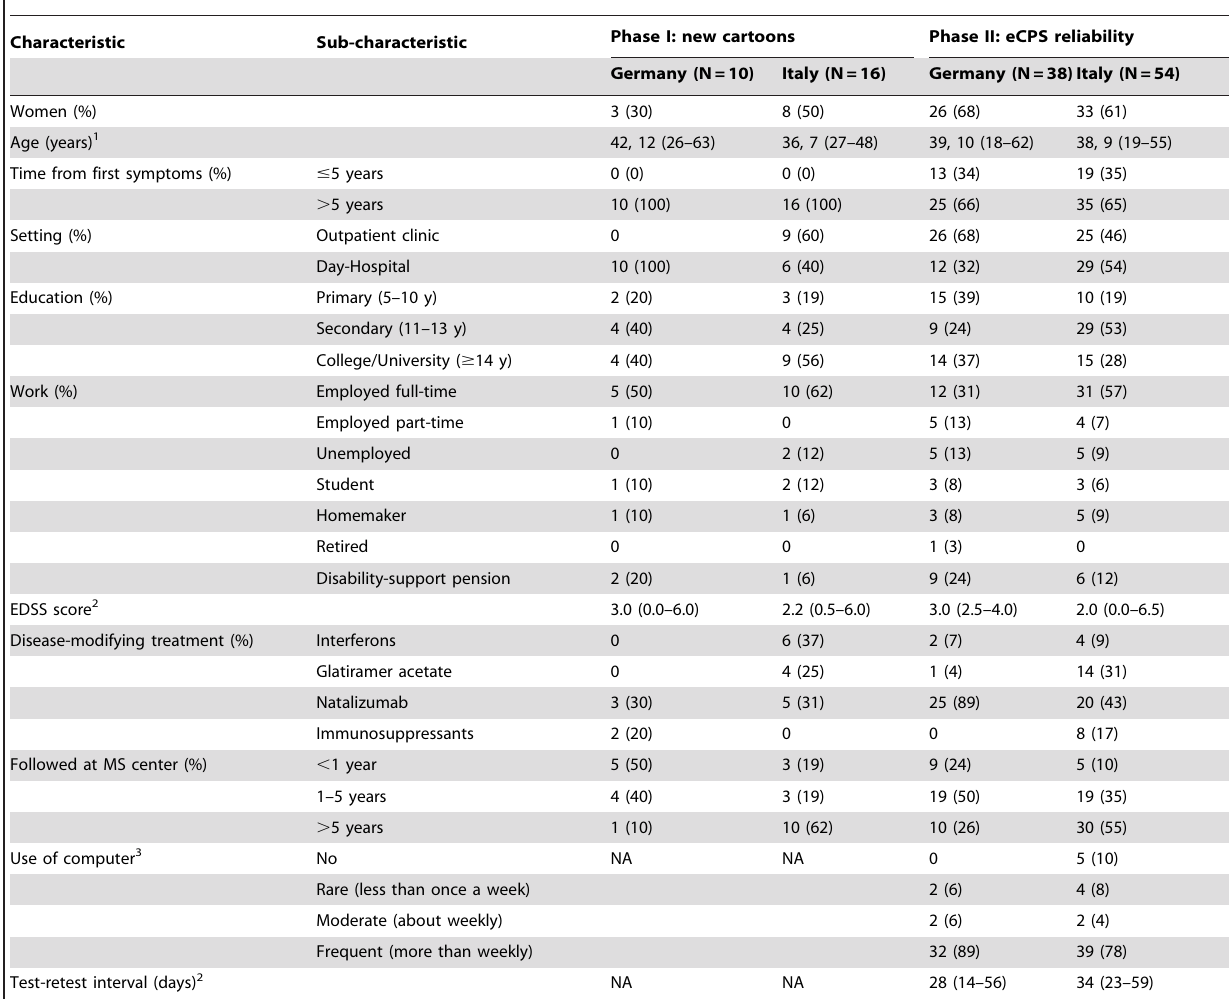
Table 1. Characteristics of the patients participating in the two study